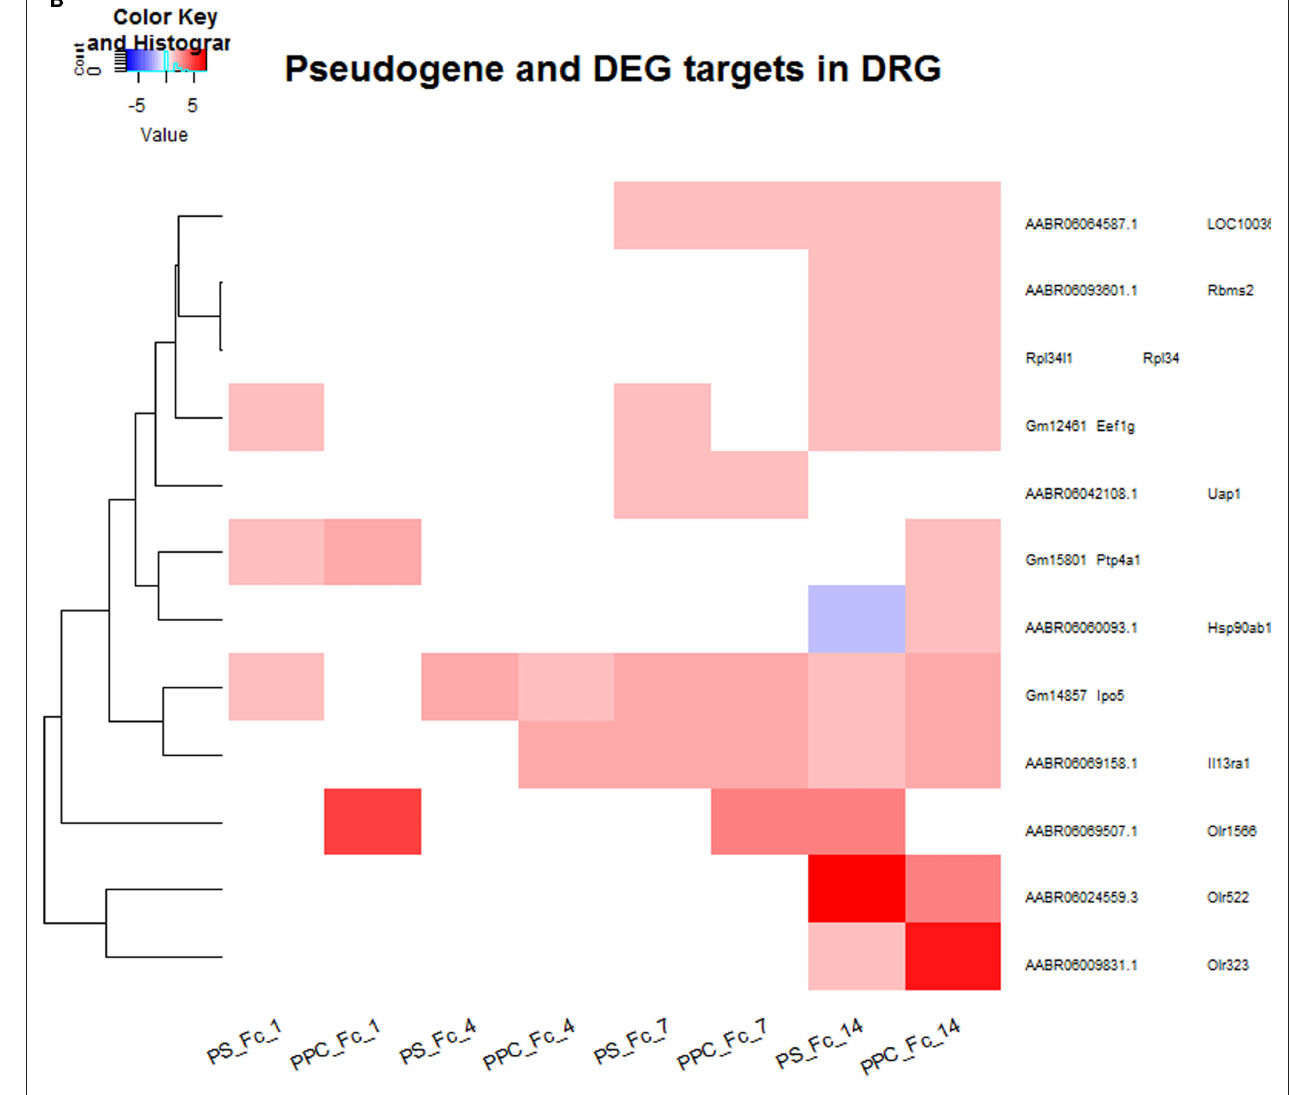
FigUre 4 | (a) Expression levels for pseudogenes and the corresponding parental protein-coding targets that are differentially expressed in SN at four different time points. (B) Expression levels for pseudogenes and the corresponding parental protein-coding targets that are differentially expressed in DRG at four different time